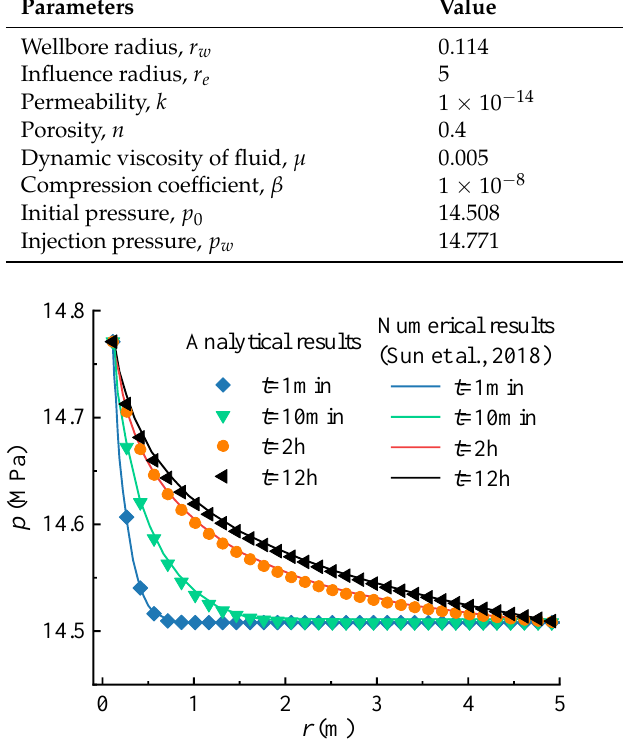
et al., 2018) [44] of the pore pressure versus distance from the wellbore wall for different times.